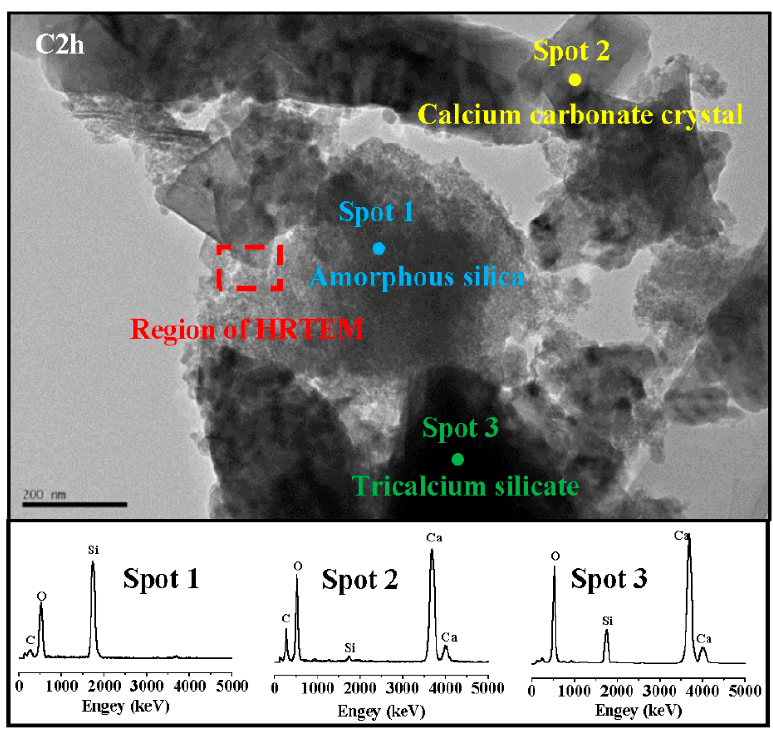
Figure 11. Transmission electron microscope (TEM) image and EDS mappings of C2h.